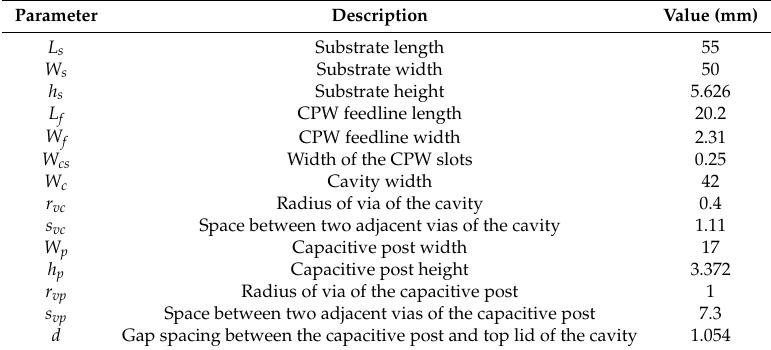
Figure 3. Geometric structure of the designed square SIW re-entrant cavity resonator: ( a ) 3-D view; ( b ) side view. Table 1. Geometric parameters of the designed resonator.